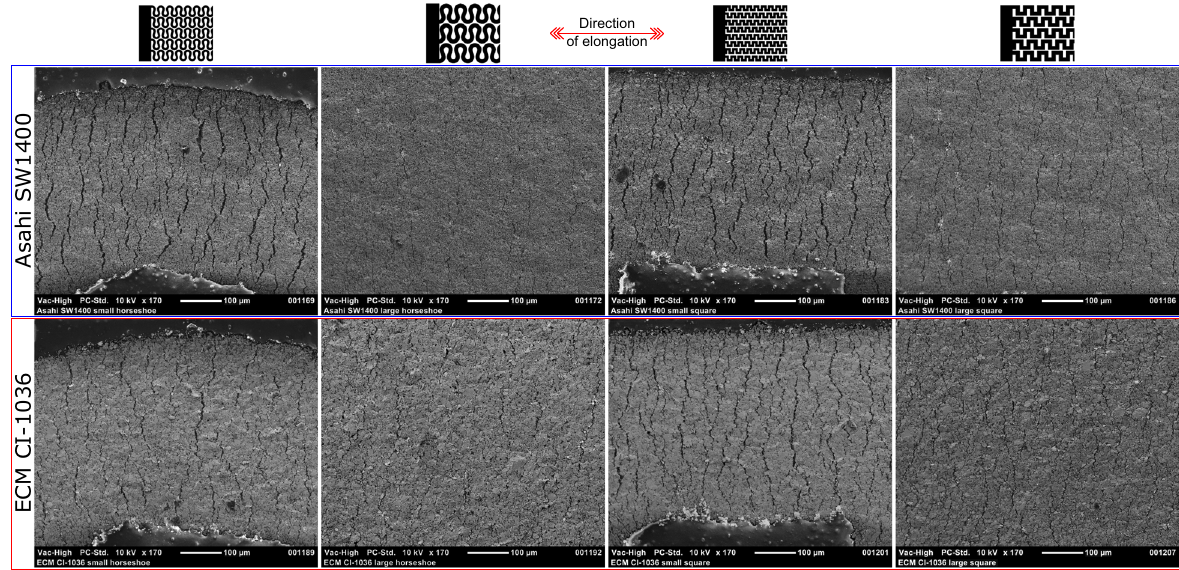
Fig. 5 SEM analysis of the in fl uence of elongation on electrodes of various size patterns for Asahi SW1400 and ECM CI-1036 pastes. SEM images at ×170 magni fi cation show a large number of wide cracks for small patterns. Although the larger patterns also show the presence of cracks, their size is notably smaller. This behavior occurs regardless of the paste used. Broaden SEM analysis for large and small patterns at various magni fi cations is available in the Supplementary Information document (Supplementary Fig. S6 and